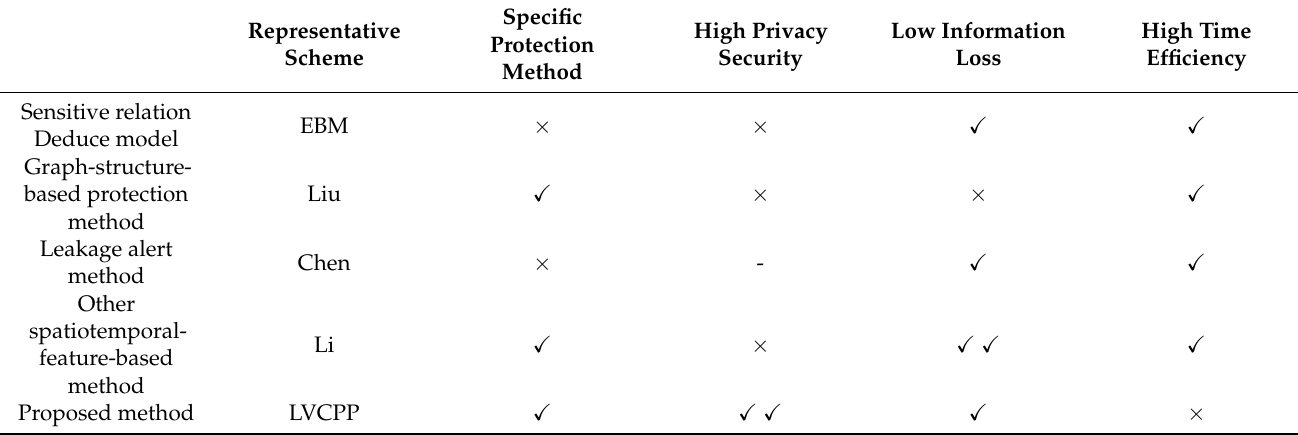
Table 4. Conclusion of